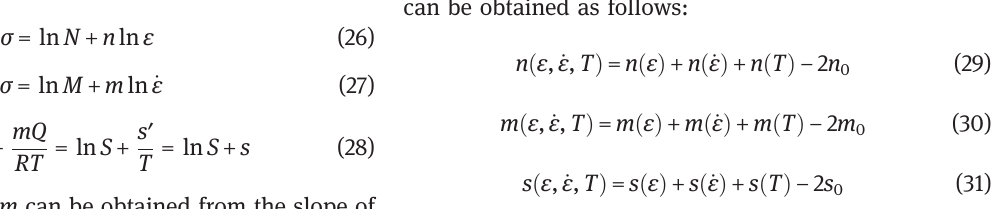
define s ′ = m Q = R, then s ′ can be acquired from the slope of lines in ln σ − 1 = T plot according to eq. (26), and s can be obtained as defined s = s ′ = T . According to Table 2, the mean stress value of σ ð ε Þ can be achieved. The value of n varying with strain can be derived from the slope of the lines in ln σ ð ε Þ − ln ð ε Þ . Subsequently, the value of n varying with strain rate and temperature can be derived from the slopes of lines in ln σ ð ε , _ ε Þ − ln ð ε Þ and ln σ ð ε , T Þ − ln ð ε Þ , respectively. The parameters m, s vary- ing with strain, strain rate and temperature can be obtained in the same way, as shown in Figure 9. The n, m , and s varying with strain, strain rate and temperature can be expressed by fifth power of polyno- mial. Coefficients of the polynomial are presented in Table 3. Three curves of n, m and s varying with strain, strain rate and temperature intersected almost at one point, with red marked in Figure 9. The n, m and s values of intersection point were 0.024, 0.077 and 3.62, respec- tively. Then the rule of n ð ε , _ ε , T Þ , m ð ε , _ ε , T Þ and s ð ε , _ ε , T Þ can be obtained as follows: